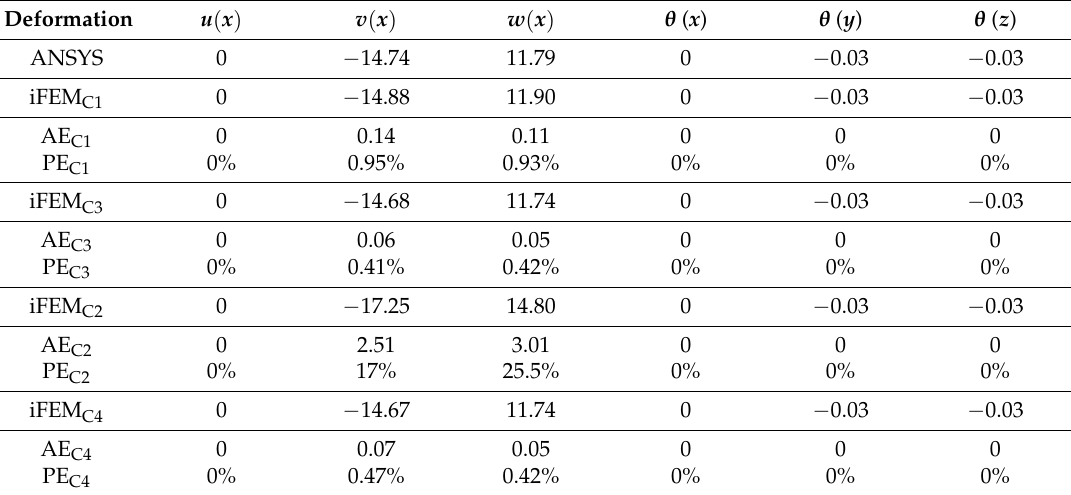
Table 2. Comparisons among deformations computed with inverse Finite Element Method (iFEM) and deformations extracted from ANSYS for end-node load (Loading A).